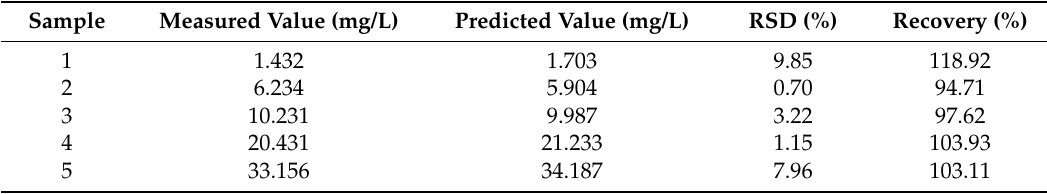
Table 3. The results between the real values and predicted values of thiabendazole pesticides in rape. Sample Measured Value (mg/L) Predicted Value (mg/L) RSD